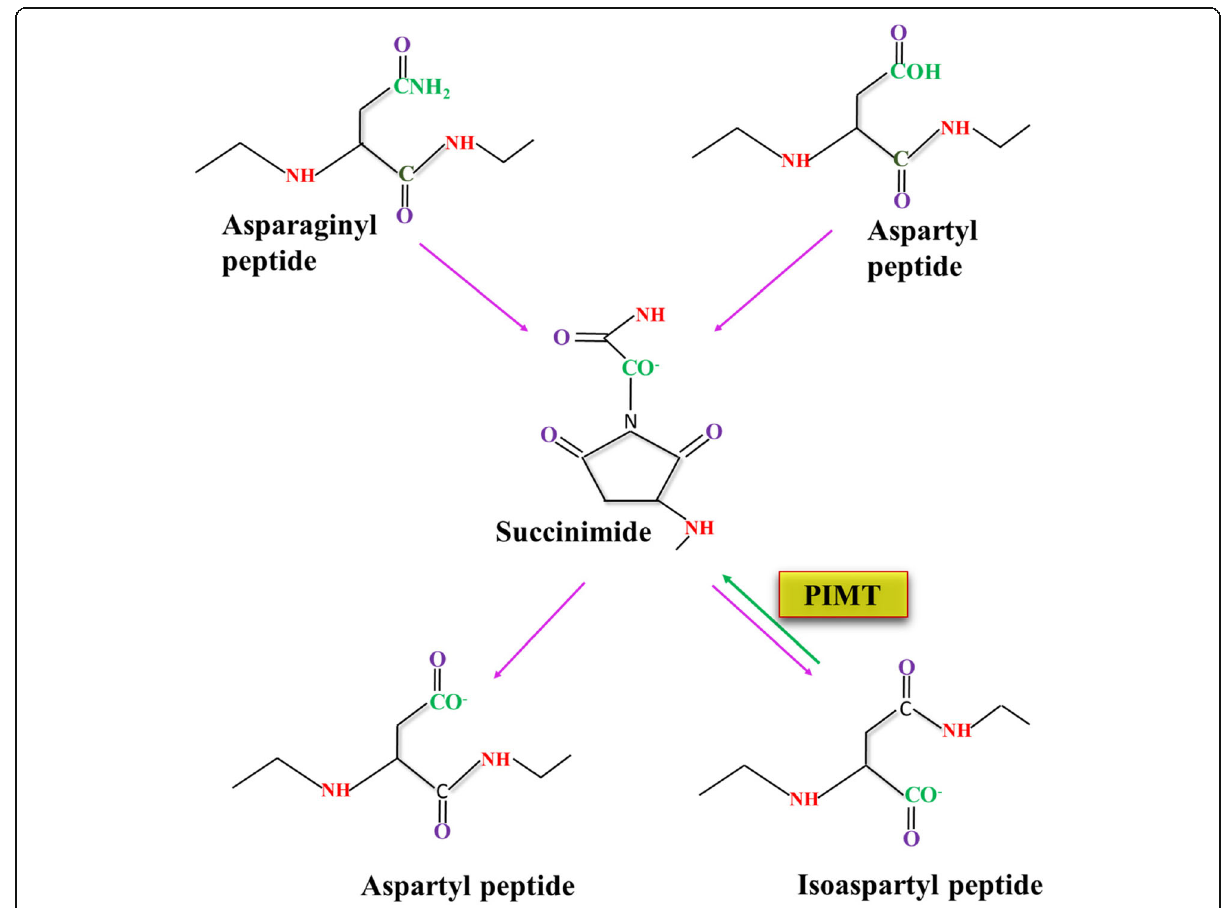
Fig. 2 Conversion of Asp to iso-Asp and their repair by PIMT: Under stress Asp or Asn residues in the proteins convert into succinimide. Succinimide spontaneously convert into normal Asp or abnormal iso-Asp residues in a ratio of 1:3. PIMT catalyzes conversion of iso-Asp residues into succinimide. Few cycles of PIMT-mediated repair converts all iso-Asp to